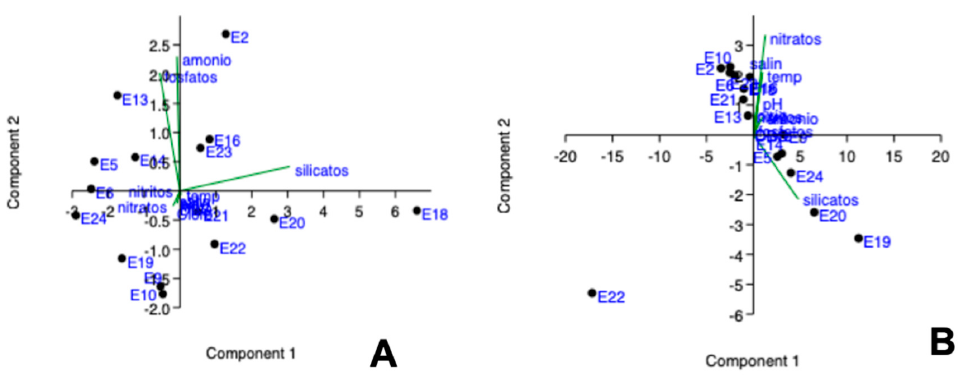
Figure 7. Principal component analysis according to the quality of the water during the dry season ( A ) and rainy season ( B ).